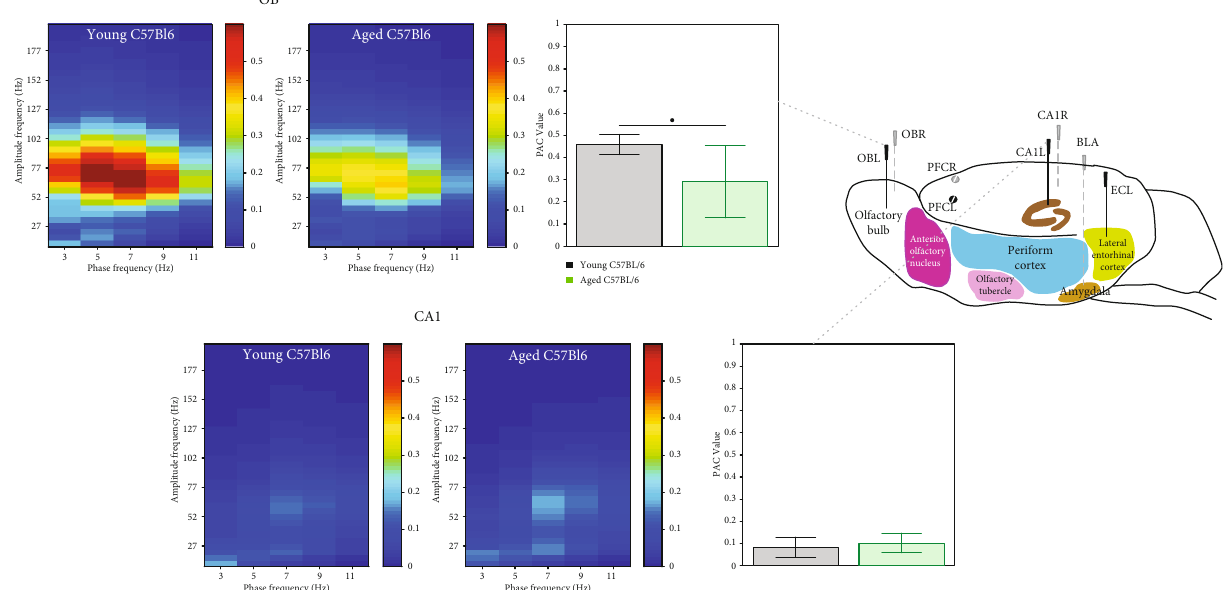
Figure 3: Heat maps showing the mean phase amplitude coupling (PAC) modulation index at the OB and CA1 recording electrodes for young (left panels in each frame) and aged (right panels in each frame) C57BL/6 mice. As shown by the color scale, “ hotter ” colors indicate high coupling values while “ colder ” colors indicate low or no coupling. Bar graphs showing the mean (across animals) theta- gamma PAC (with 95% CI) at the OB, EC, and CA1 electrodes for young (black, n = 7 ) and aged (green, n = 8 ) Bl6 mice. These means along animals ’ PAC values were computed as the average PAC for the large window of phase frequency: 2 – 12 Hz, and amplitude frequency: 10 – 200 Hz. Right bar charts show estimated mean PAC index phase 4-8 Hz and amplitude 40-100Hz, and horizontal lines above bar plots with asterisks indicate presence of signi fi cant di ff erence between genotypes ( ∗ p value < 0.05). Data are presented as mean values (with 95% CI).